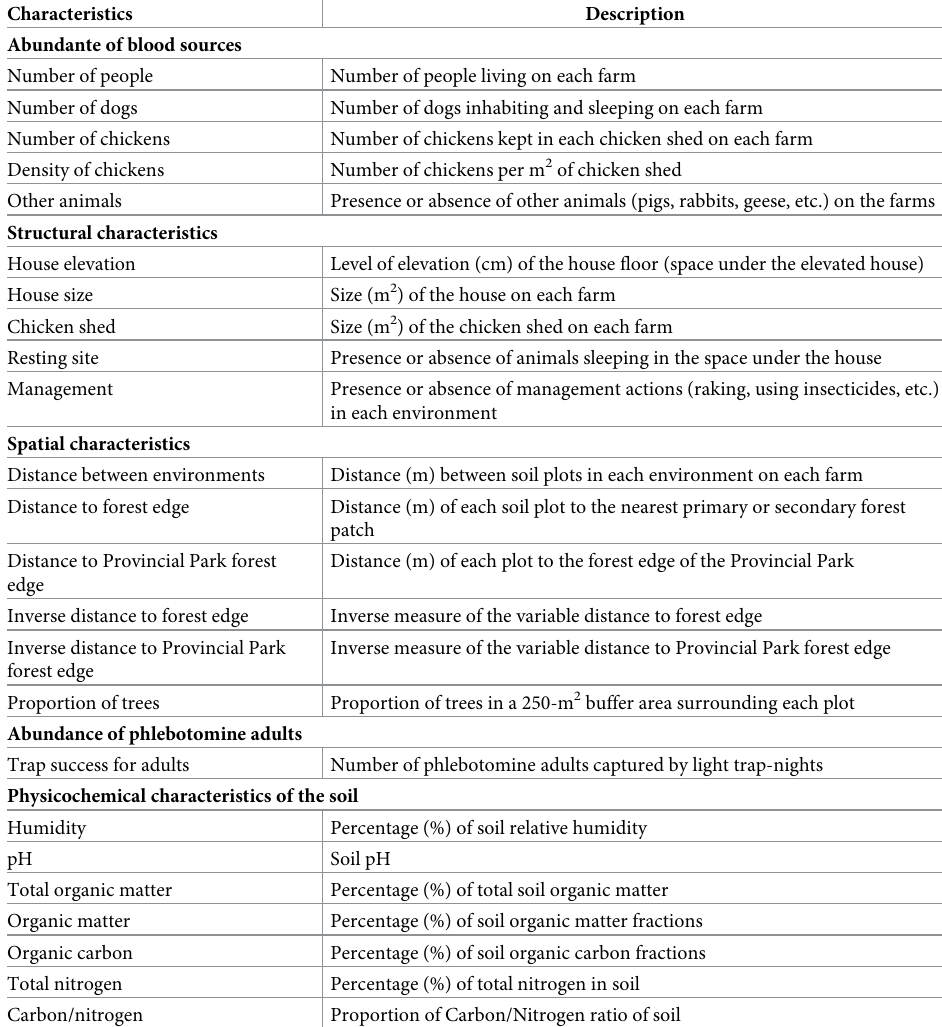
Table 1. Environment and structural characteristics recorded on eight farms and physicochemical characteristics of soil taken from three farms of the "Dos Mil Hecta´reas" area during the second period of collection of newly emerged phlebotomines: blood sources, structural and spatial characteristics, adult phlebotomine abundance, and soil physicochemical